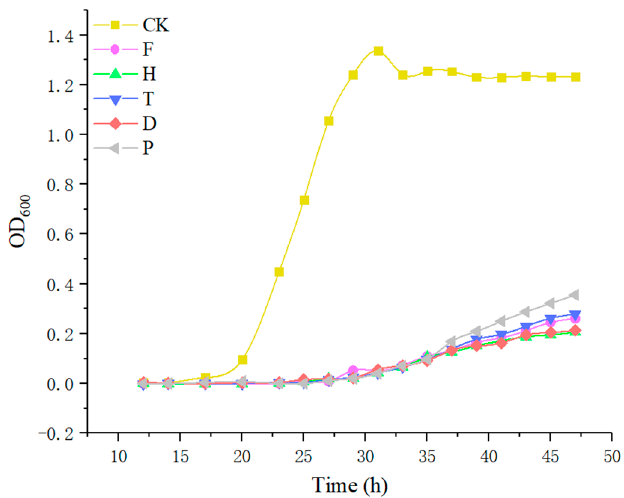
Figure 2. The growth curve of yeast exposed to the maximum residual amount of F, H, T, D, and P. Note: CK, blank control group; F, flutriafol; H, hexaconazole; T, tebuconazole; D, difenoconazole; P,